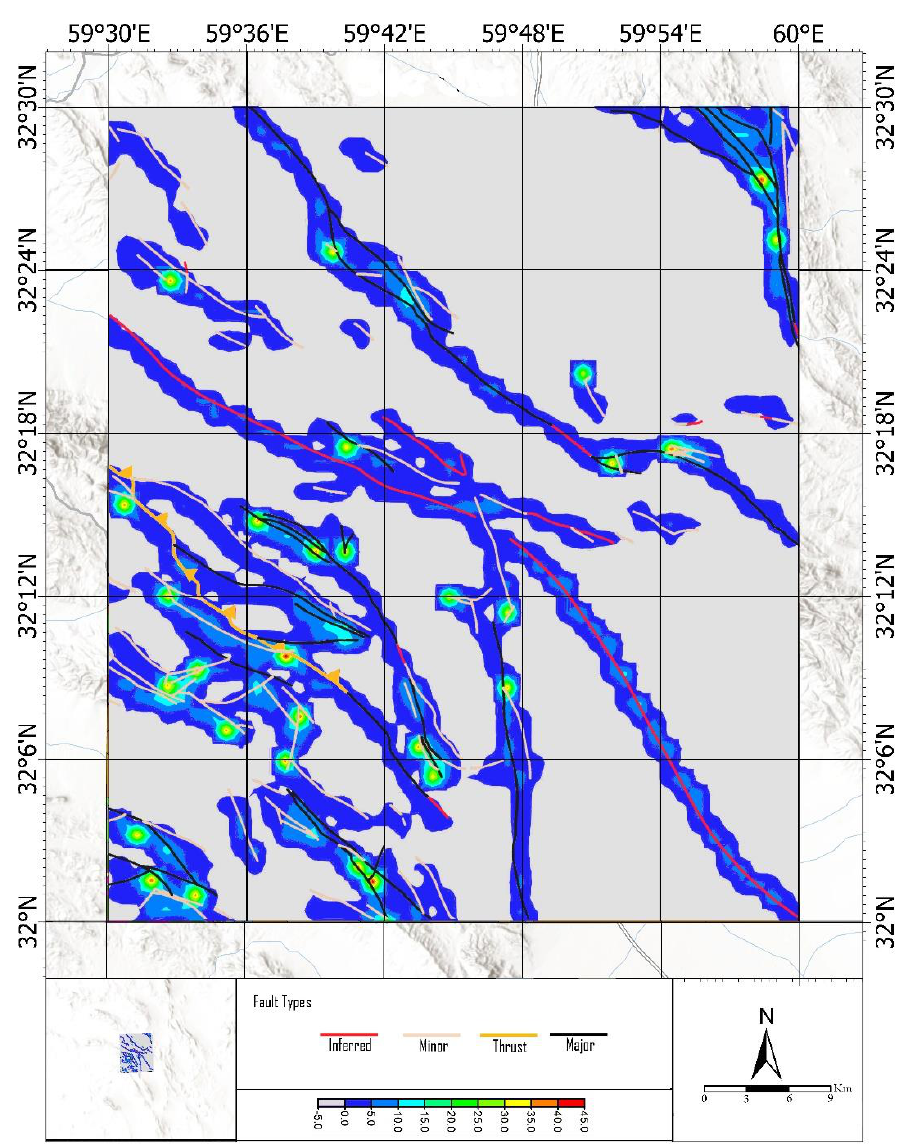
Figure 8. Lineament factor (LF) map of Sahlabad area. The faults in the map are divided into four categories, inferred, minor, thrust and major, which are marked with red, cream, yellow and black colors, respectively. Faults were identified using information extracted from the geological map (Geological Survey of Iran (GSI)).